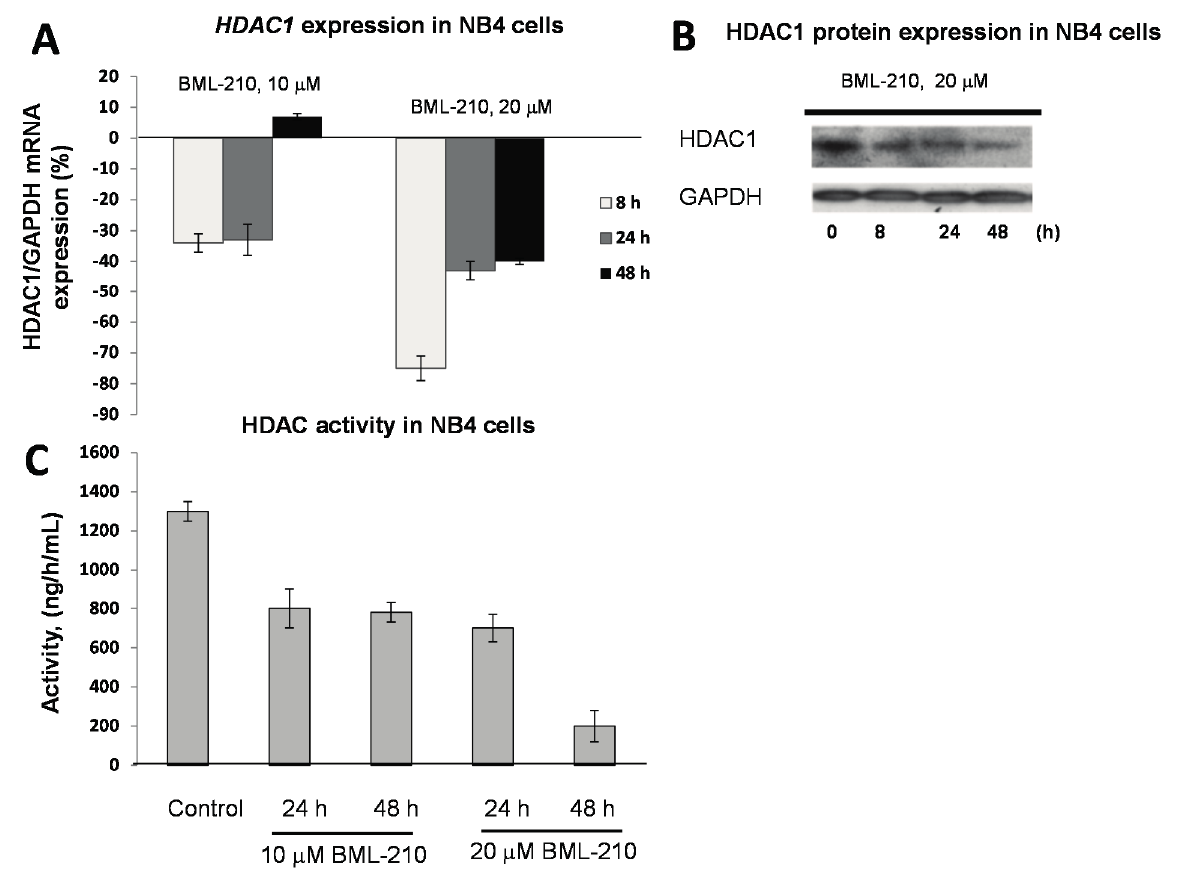
Figure 2. Expression of HDAC1 in response to BML-210 treatment. HDAC